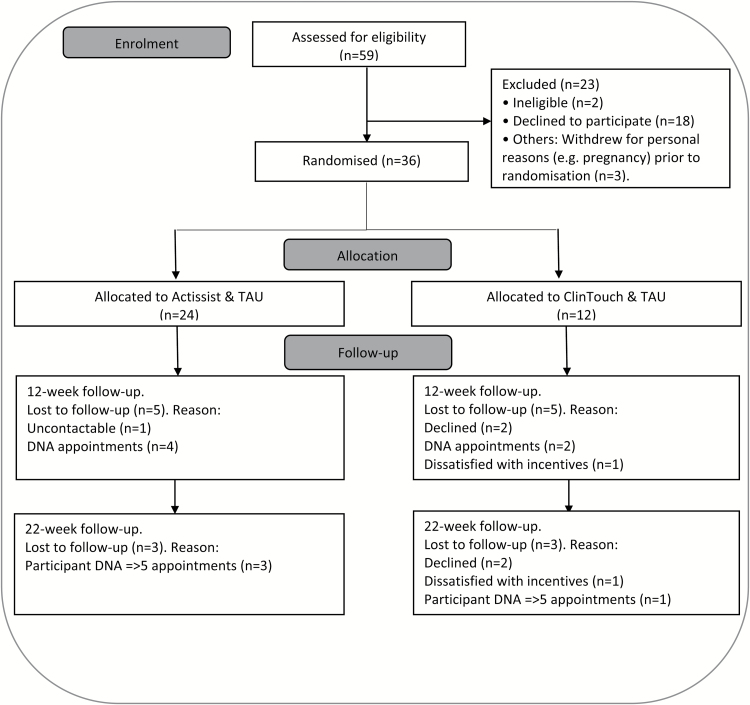
CONSORT diagram.